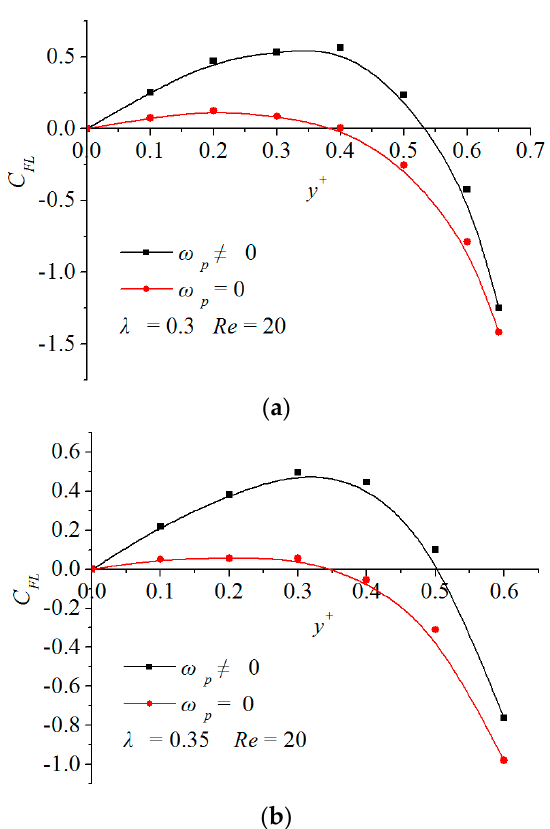
Figure 5. Rotational effect of particles on the inertial lift force: ( a ) is for λ = 0.3 and ( b ) is for λ = 0.35 at Re = 20.